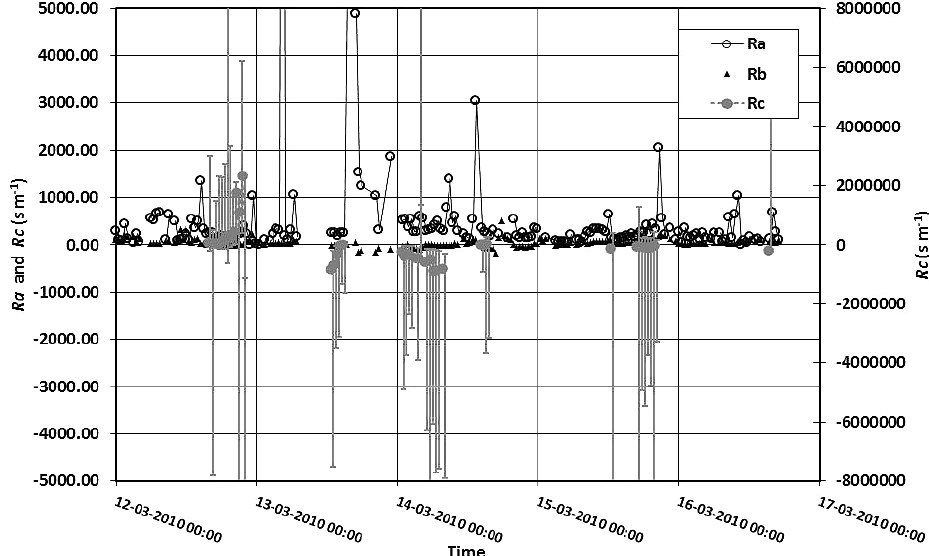
Fig. 6. Development of Rc , Ra and Rb from 12 to 16 March. The mean Ra is 5.24 × 10 2 sm − 1 ranging from 0.05 × 10 2 to 236.32 × 10 2 sm − 1 and mean Rb is 0.43 × 10 2 sm − 1 ranging between 5.14 × 10 2 and − 1.68 × 10 2 sm − 1 . The Rc (mean − 1.07 × 10 7 sm − 1 ranging between 1.1 × 10 7 and − 17.1 × 10 7 sm − 1 ) is several orders of magnitudes higher than Ra and Rb . The error bars around Rc are based on the calculated maximum and minimum values of p CO 2 in the surface brines.